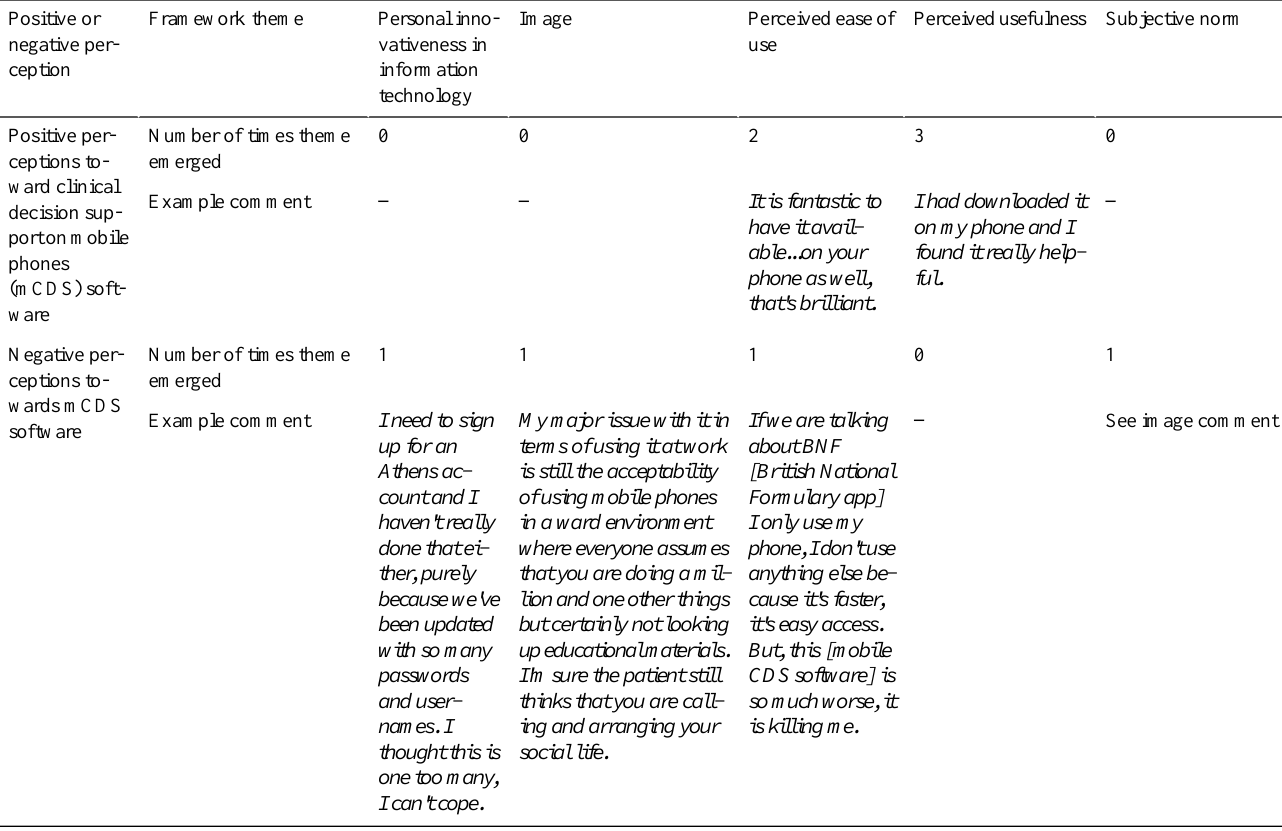
Table 3. Summary of the framework analysis of junior doctor perceptions of clinical decision support on mobile phones (themes that did not emerge have been removed).